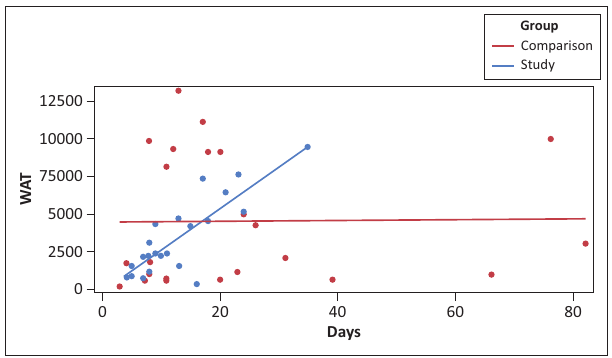
FIGURE 5: Relationship between water consumed and days of intervention for the study and comparison